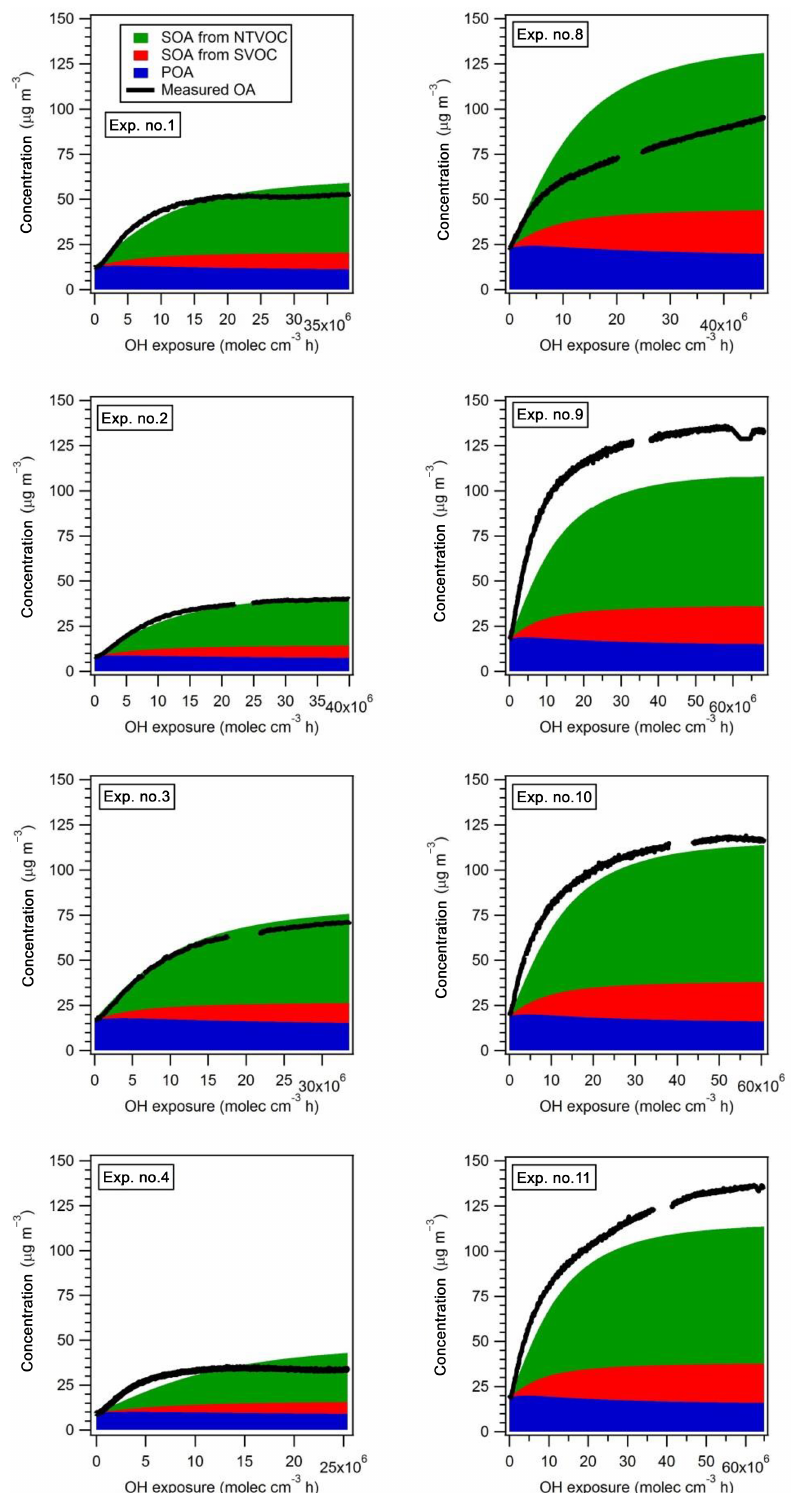
Figure 4. Modelled and observed OA mass for low-temperature experiments (left side) and high-temperature experiments (right side). The model results are for the best-fitting solution (yellow diamond in Fig. 3). SOA from NTVOCs and SVOCs as well as POA are reported in green, red and blue,